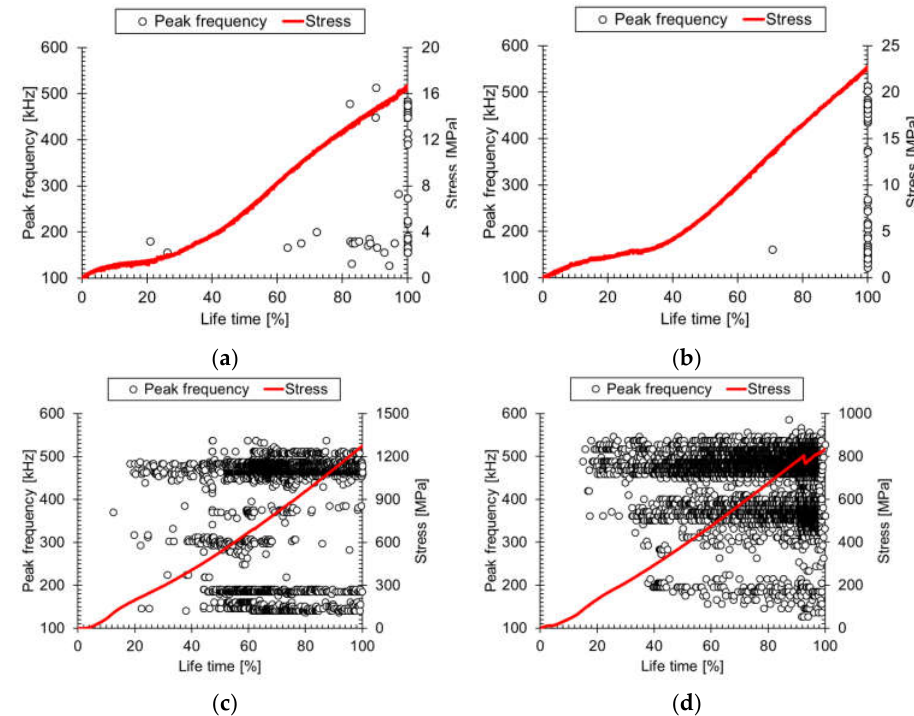
Figure 6. Distribution of peak frequency over the lifetimes of ( a ): [90] 16 , ( b ): [80] 16 , ( c ): [0] 8 , and ( d ): [0/90] 4 .